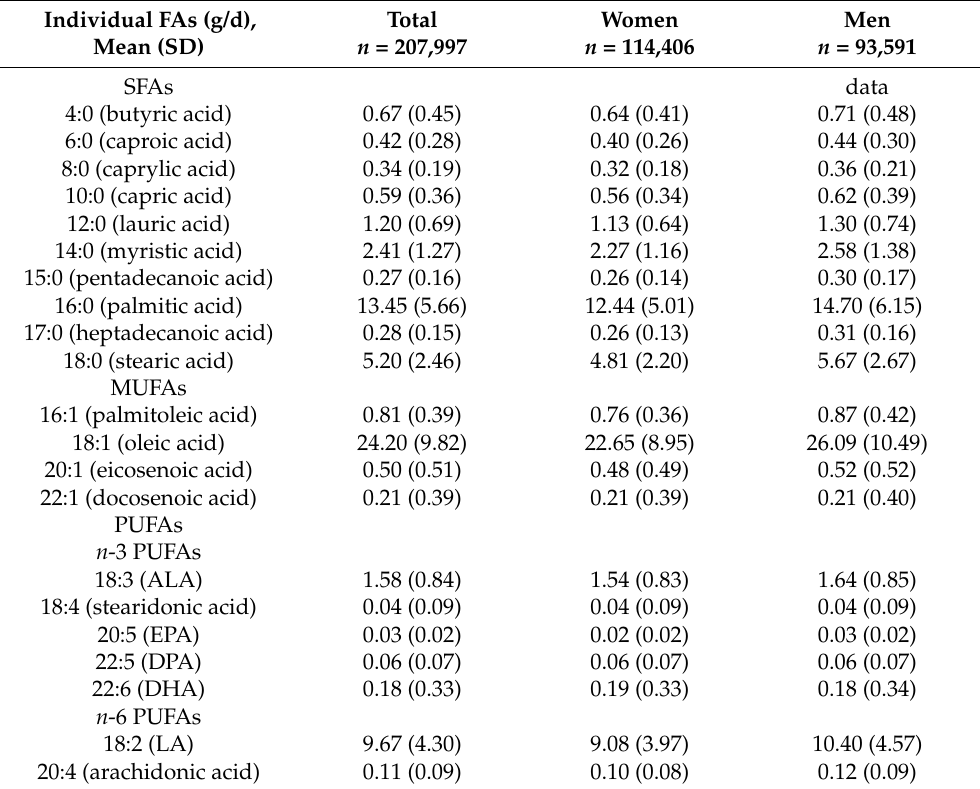
Table 1. Intakes of individual FAs incorporated into the new individual FA dataset (MCW + USDA) in 207,997 UK Biobank participants.